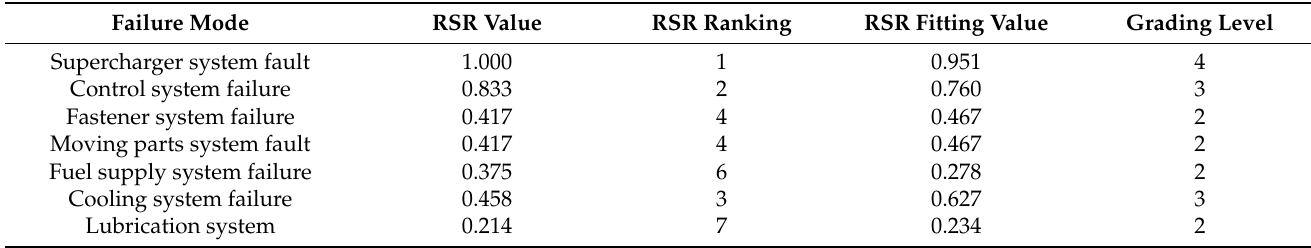
Table 9. The FHA sorting